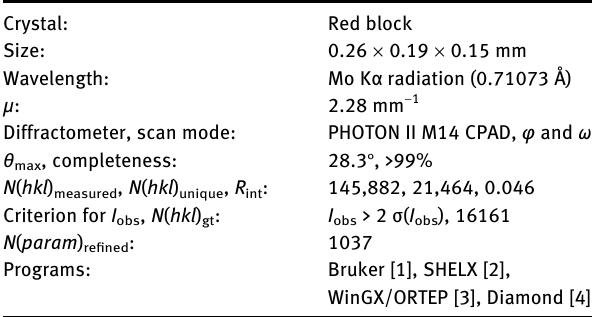
Table  : Data collection and